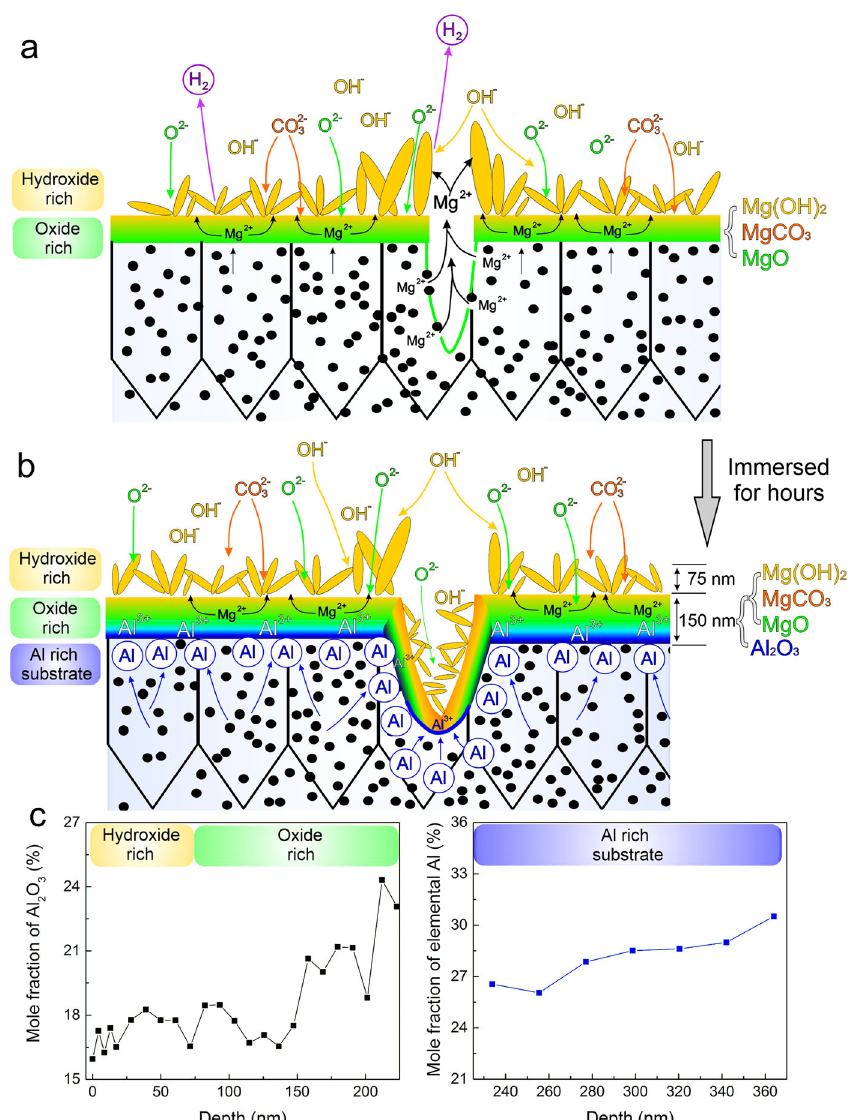
Fig. 6 Structure of passivation fi lm. Schematic diagrams showing laser powder-bed fusion AZ111 alloy immersed in NaCl ( a ) at the initial stage and ( b ) after hours of immersion when passivation is developed. c XPS showing mole fraction of Al 2 O 3 among compounds in the hydroxide-rich and oxide-rich layers, and mole fraction of elemental Al among metallic elements in the Al-rich